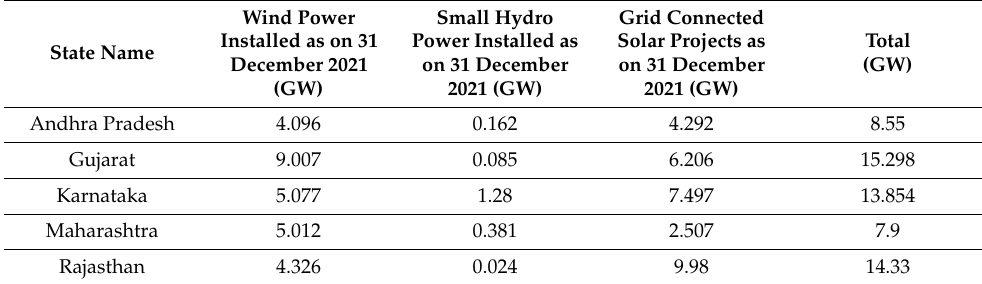
Table 2. Installed capacities of renewable energy in high-potential states